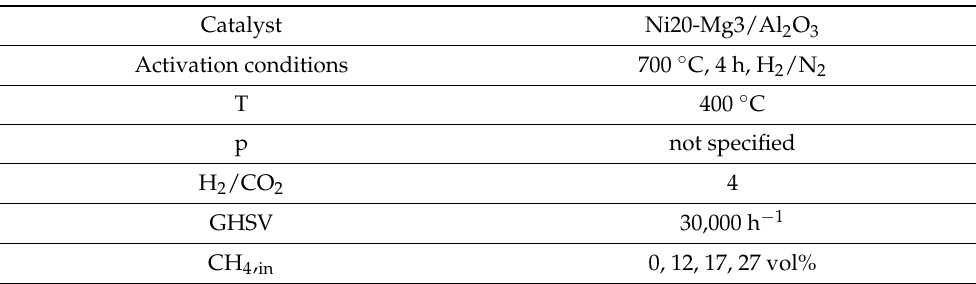
Table 6. Catalyst and reaction conditions for experiments on CH 4 influence on methanation over Ni/Al 2 O 3 with Mg promoter [98].